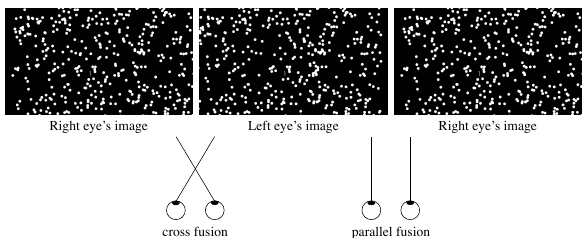
Figure 1. Stimulus configuration used in the experiment: Left and center panels are for cross fusion, and center and right panels are for parallel fusion. By means of free-fusing, both cross and parallel fusers can make an impression on the 3D structure of the stimulus. The numeral “1” indicates the target (presented near the center).